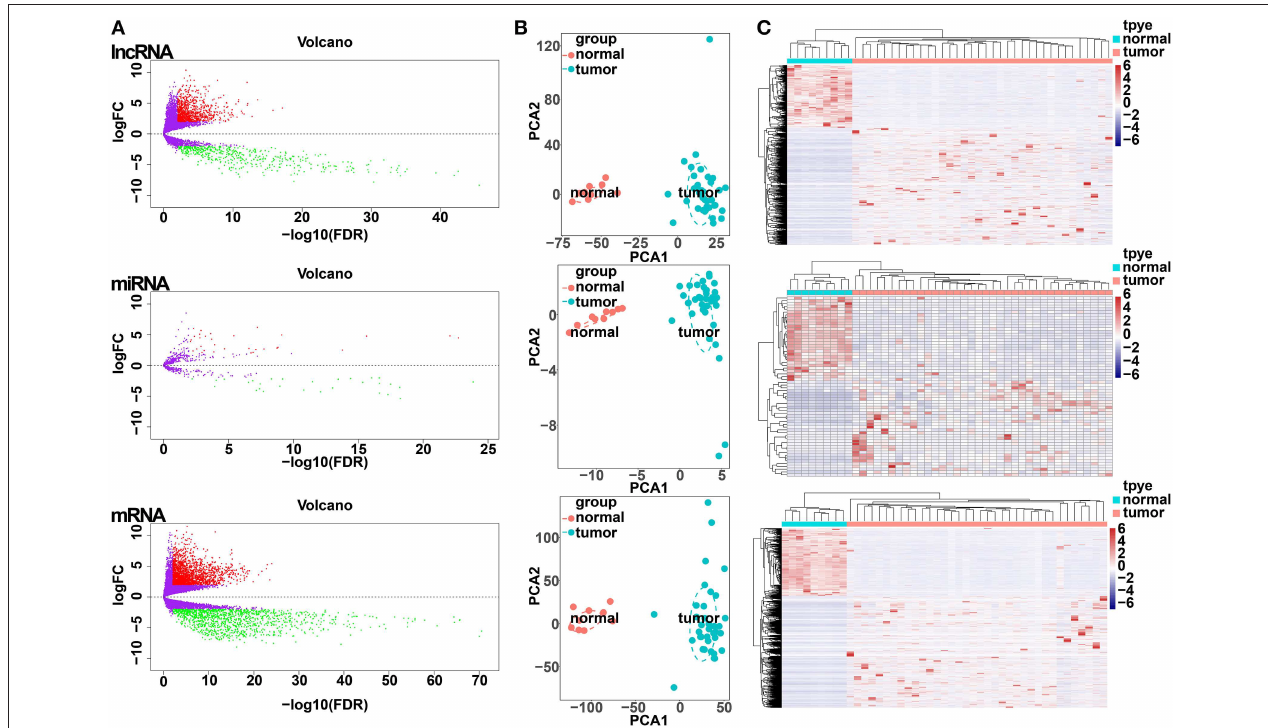
FIGURE 1 | Differentially expressed gene (DEG) analysis. (A) Volcano plots of differentially expressed lncRNAs (upper panel), miRNAs (middle panel), and mRNAs (lower panel). The Y-axis represents the negative log (base 10) of the FDR, and the X-axis represents the log (base 2) of FC. Each point represents a gene. The dots in green denote downregulated DEGs, the dots in red denote upregulated DEGs, and the dots in black denote non-DEGs. (B) Principal components analysis (PCA) plot of the differentially expressed lncRNAs (upper panel), miRNAs (middle panel), and mRNAs (lower panel). The tumor samples (green, n = 36) and normal samples (red, n = 9) are plotted along the axis about the first two principal components (PC1 and PC2). (C) Heatmap plots of the differentially expressed lncRNAs (upper panel), miRNAs (middle panel), and mRNAs (lower panel). The horizontal axis represents the samples, and the upper horizontal axis represents the sample clusters. The vertical axis represents the DEGs, and the left vertical axis shows the DEG clusters. Red represents upregulated genes, while green represents downregulated genes.